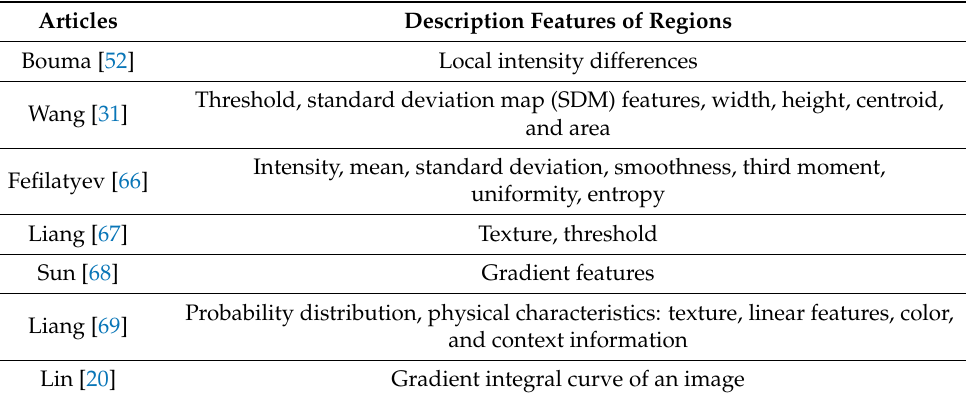
Table 2. The features used to describe regions in sea–sky line detection.